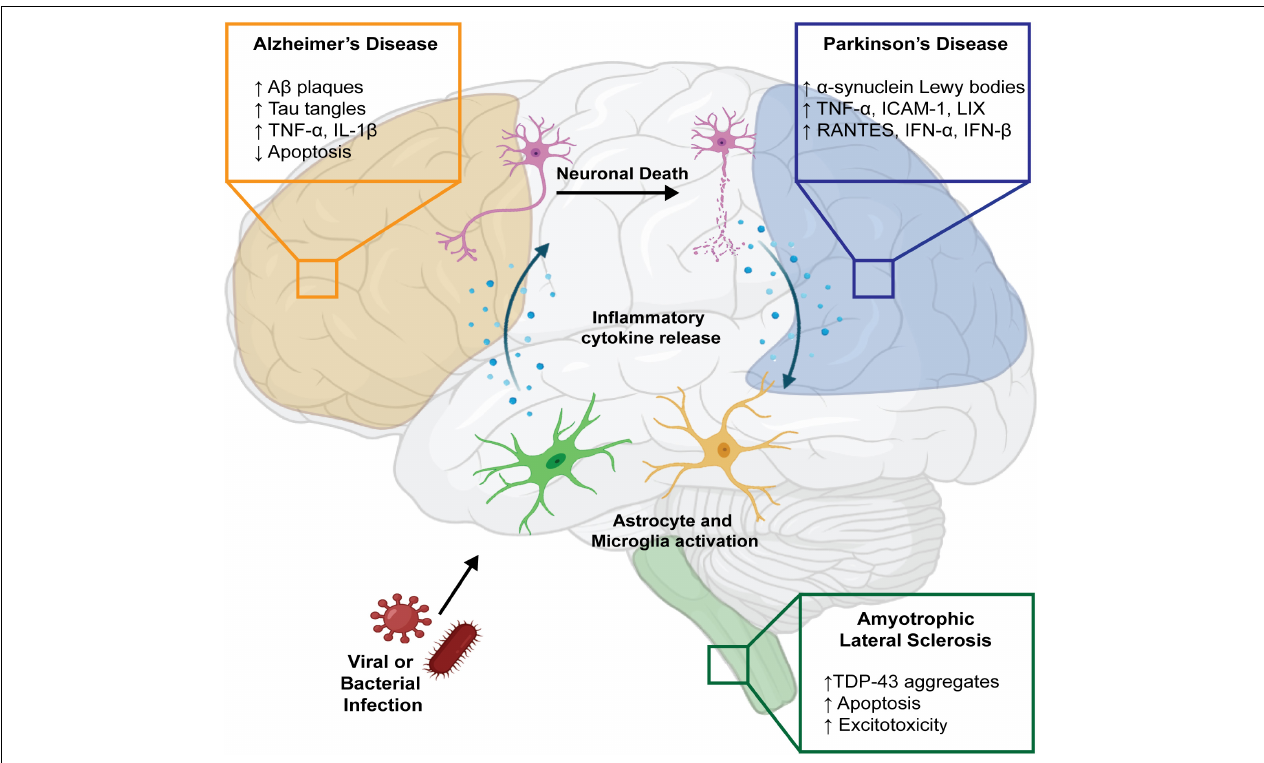
FIGURE 1 | Infectious agents may contribute to neurodegenerative diseases directly or via immune activation. Infection by viral and bacterial pathogens can cause pro-inflammatory activation of CNS resident immune cells, including astrocytes and microglia, resulting in neuronal death. Additionally, cellular death directly caused by infectious agents and the release of damage-associated molecular patterns can exacerbate the inflammatory state through further activation of CNS immune cells, perpetuating a cycle of inflammation. In AD, this is often associated with high levels of pro-inflammatory cytokines TNF- α and IL-1 β , reduced clearance of infected cells, and accumulation of neurotoxic aggregates composed of A β and Tau. This pro-inflammatory state has also been documented in the context of PD, where increased accumulation of neurotoxic α -synuclein is accompanied by high levels of TNF- α , ICAM-1, LIX, RANTES, IFN- α , and IFN- β , produced by infected and activated astrocytes and microglia. Additionally, some pathogens can directly infect neurons resulting in alterations in metabolism, enhanced neuronal excitotoxicity, and enhanced apoptosis, as seen in ALS. Created with